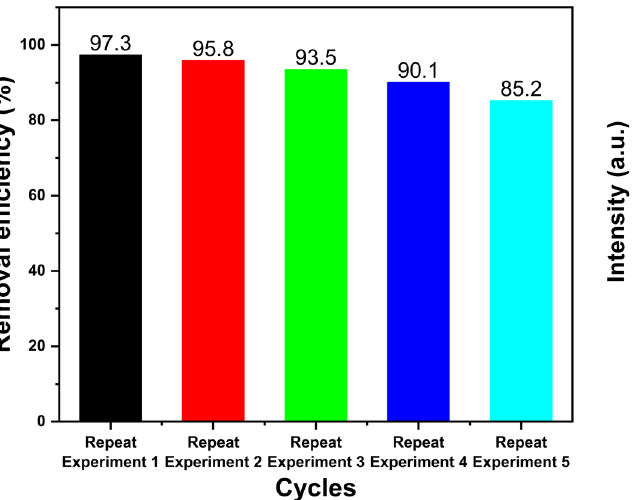
Figure 9: XRD patterns of Ag@AgCl – ARB photocatalyst before and after the photocatalytic experiment.